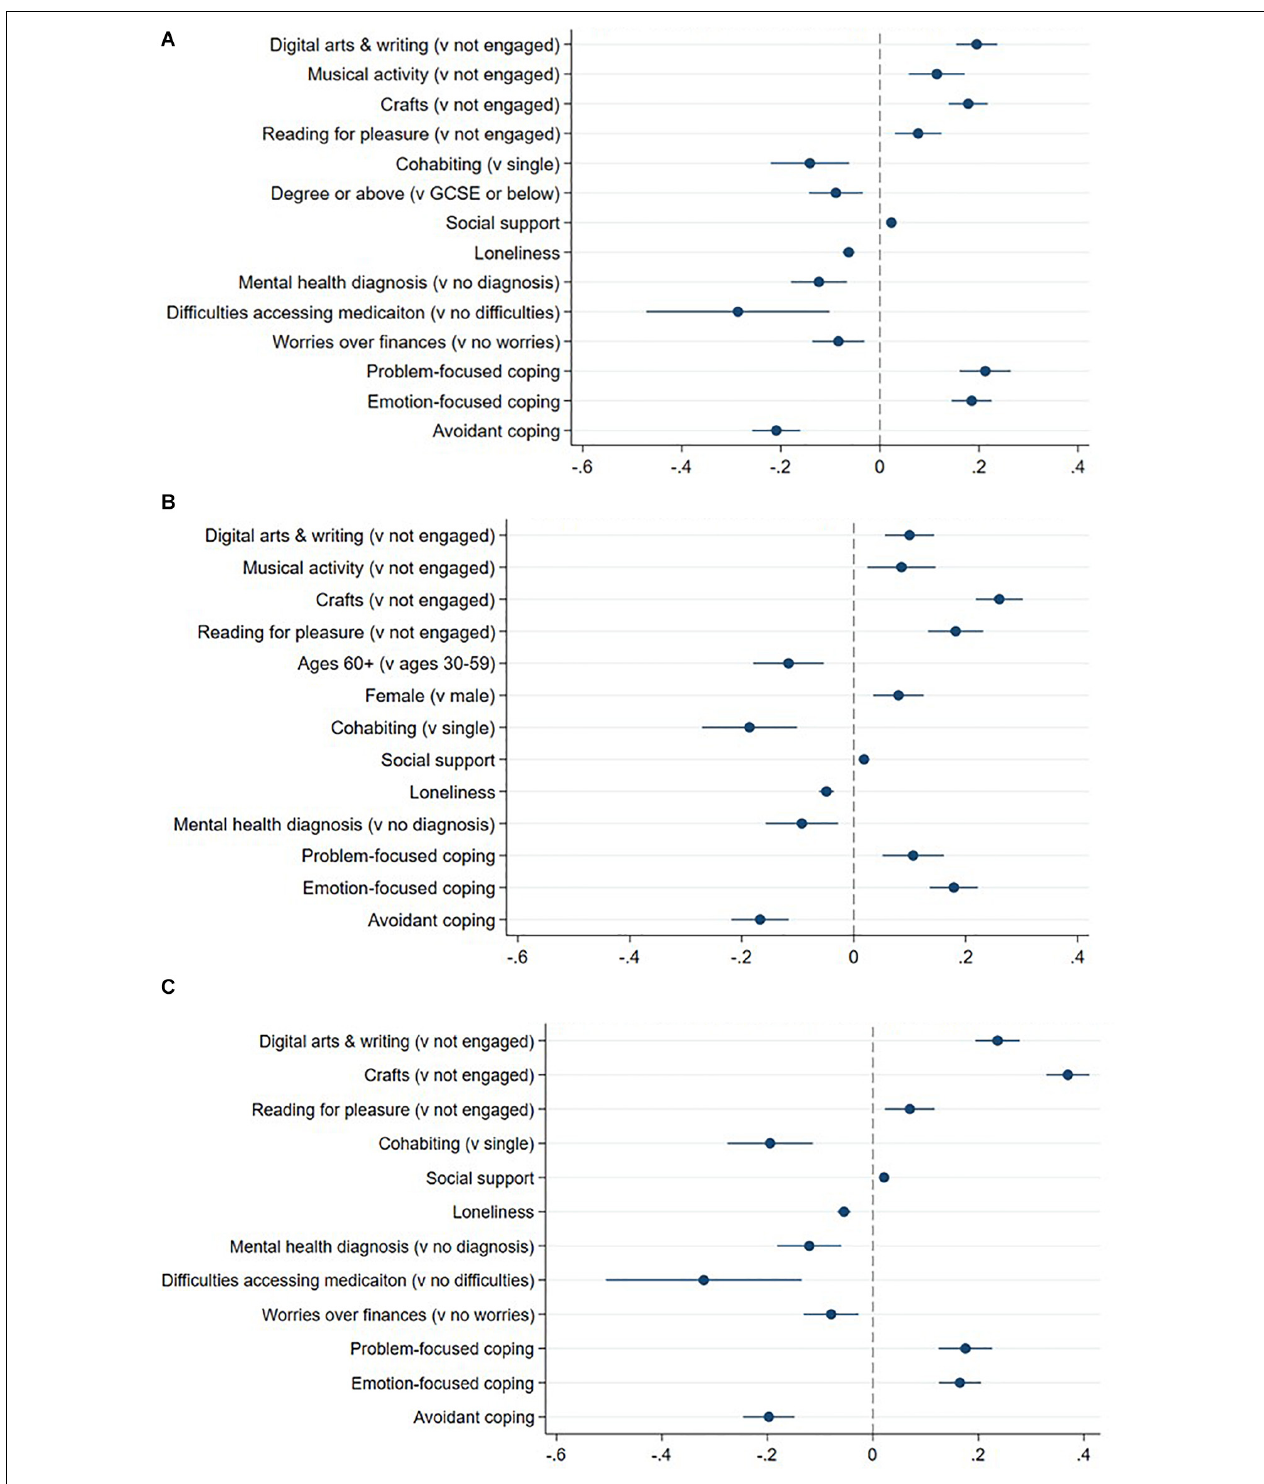
FIGURE 3 | (A) Approach strategy through arts activities. Panel (A) shows coefficients and 95% CIs from OLS regression; the model was adjusted for all covariates. Only results with p < 0.01 are shown. (B) Avoidance strategy through arts activities. Panel (B) shows coefficients and 95% CIs from OLS regression; the model was adjusted for all covariates. Only results with p < 0.01 are shown. (C) Self-development strategy through arts activities. Panel (C) shows coefficients and 95% CIs from OLS regression; the model was adjusted for all covariates. Only results with p < 0.01 are